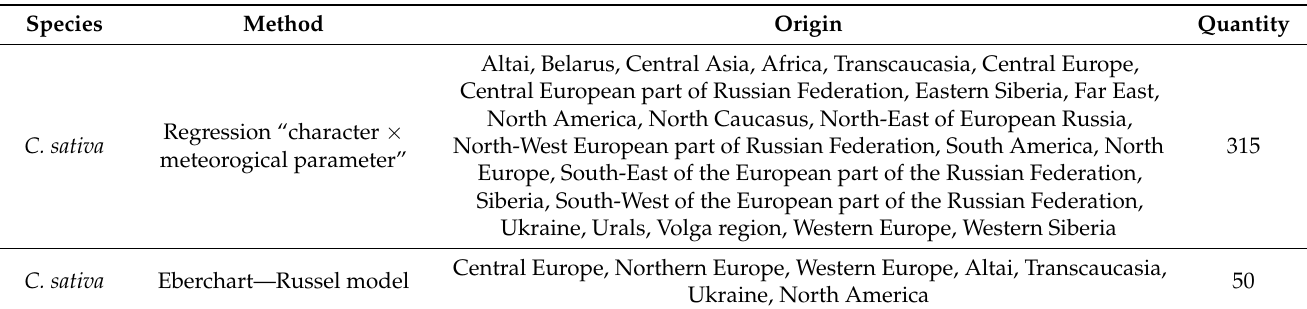
Table 1. List of C. sativa accessions from the VIR collection used as a research material.